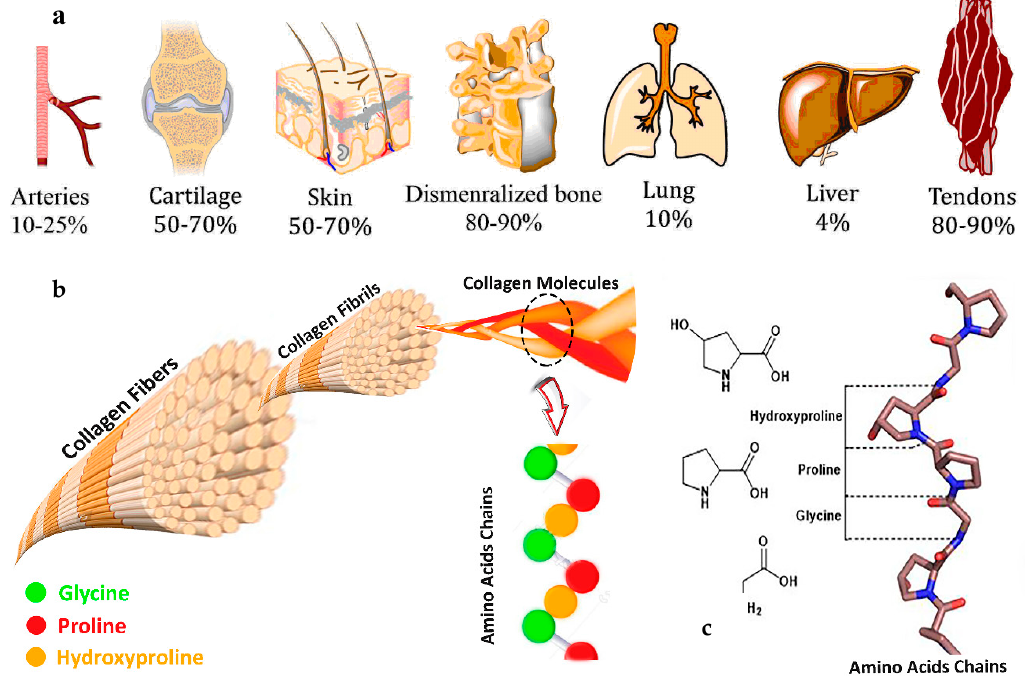
Figure 1. ( a ) Approximate content of collagen in different tissues; values are from https://www.elsevier.com/es-es/connect/medicina/colagenos-tipos-composicion-distribucion-tejidos. ( b ) Structure of collagen fibers, fibrils, triple helices of alpha chains and amino acid residues, 4-hydroxyproline (Hyp), glycine (Gly), and proline. ( c ) Amino acids chains structure of collagen.